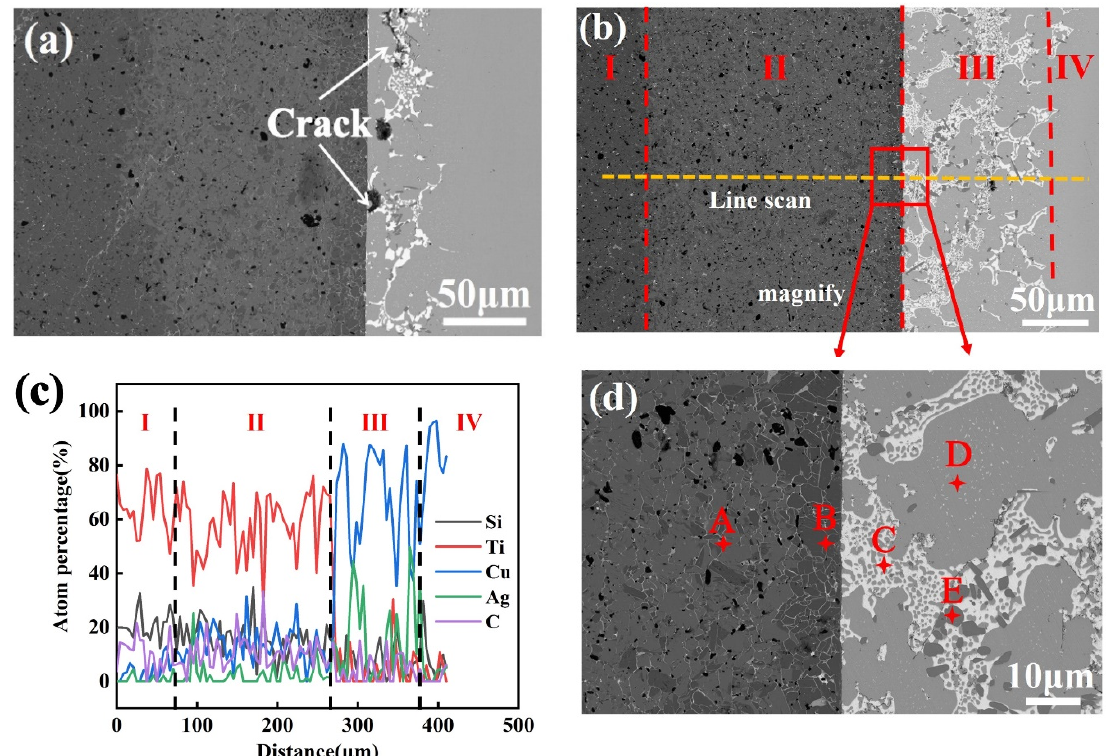
Figure 4. Interfacial microstructure of Ti 3 SiC 2 /Cu brazed joints using Ag-Cu-Ti filler ( a ) without copper mesh ( b ) with copper mesh at 880 °C for 10 min and ( c ) elemental EDS line profile result in ( b , d ) high-magnified image of zone in ( b ).